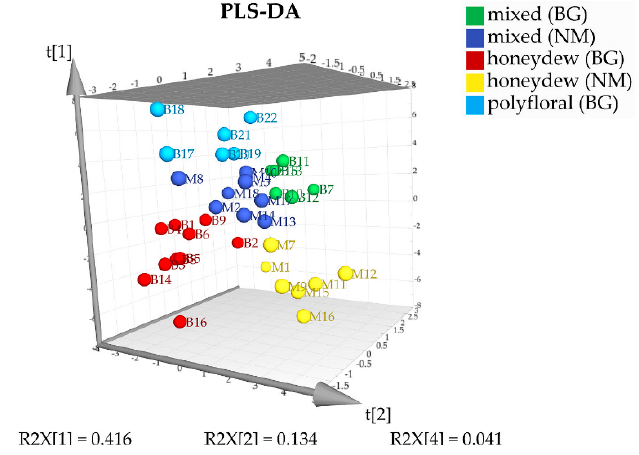
Figure 5. PLS-DA 3D score plot of the honey samples.